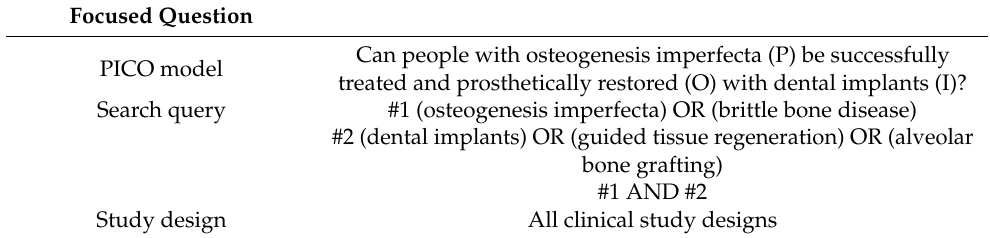
Table 1. Focused question using the PICO approach and search query for the databases. Focused